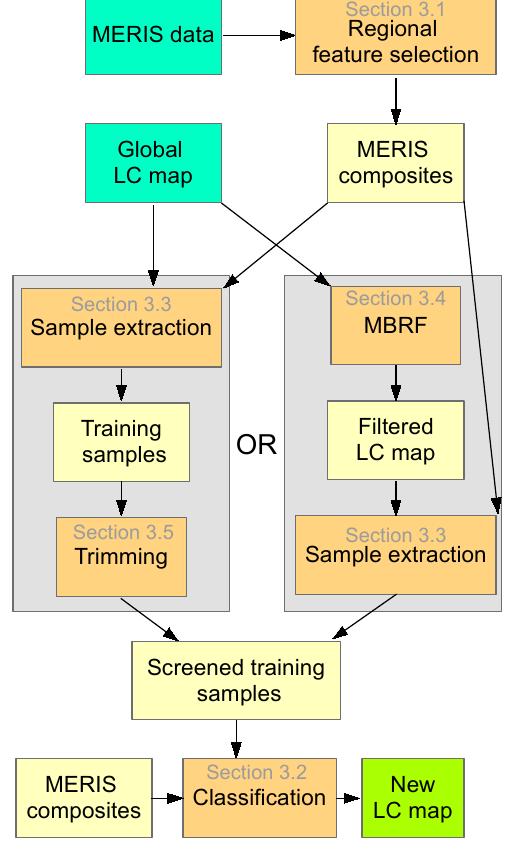
Figure 2. Overview of the method, including the two options used to mitigate the errors in the training datasets (MBRF stands for multiclass border reduction